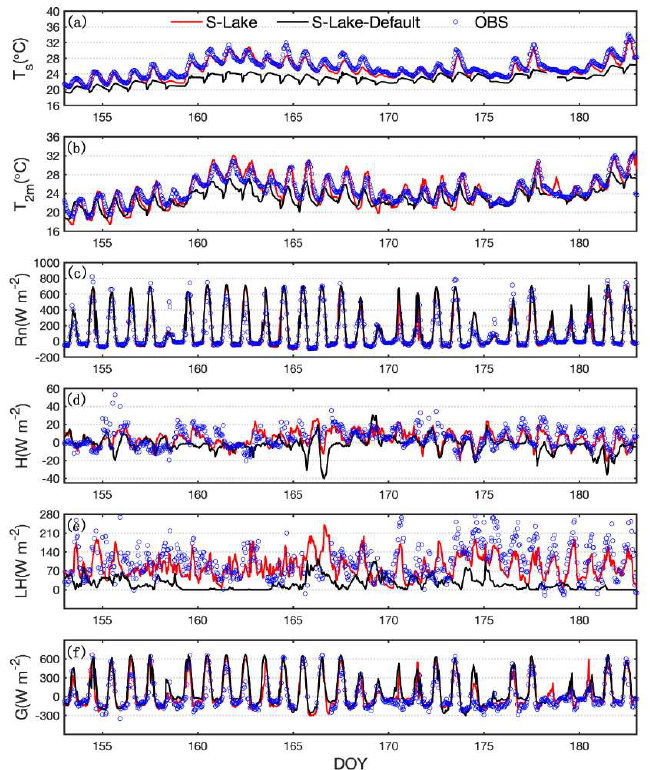
Figure 2. Modeled and observed temporal evolution of ( a ) skin temperature (°C), ( b ) air